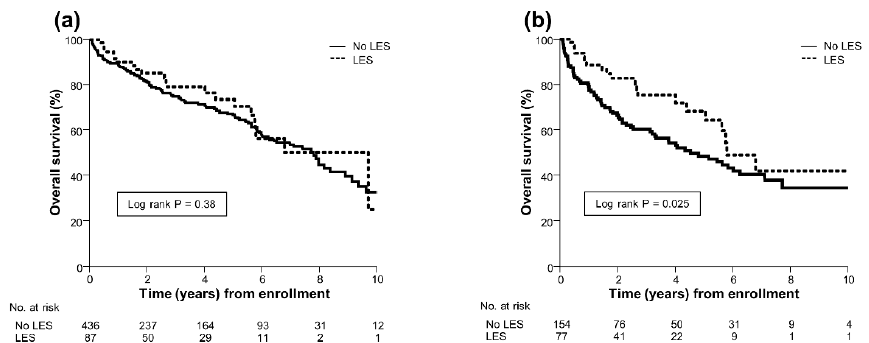
Figure 1. ( a ) Overall survival of 87 LES-treated patients and 436 untreated patients. ( b ) Overall survival of 77 LES-treated patients and 154 untreated patients after propensity score matching analysis. Overall survival was estimated using the Kaplan–Meier method and compared between groups using the log-rank test. LES, late evening snack.